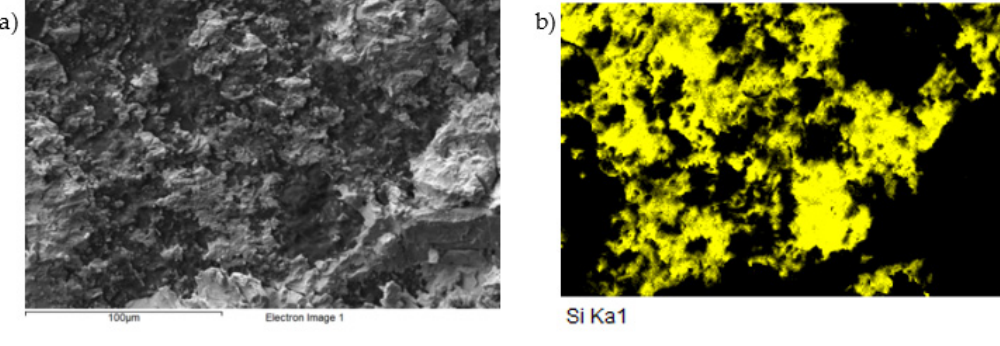
Figure 24. Fractured surface of soldered joint of Si/BiAg11Ti1,5/Cu and the planar distribution of elements ( a ) fracture structure; ( b ) Si; ( c ) Ti; ( d ) Ag; ( e ) Bi; ( f ) Cu.